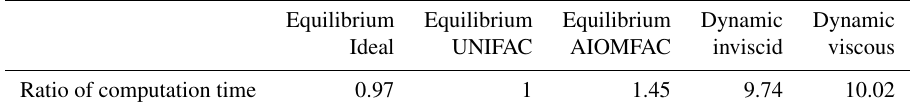
Table 5. Comparison of the time elapsed for the simulations. The elapsed time for the Equilibrium UNIFAC simulation is set to a reference time. Ratios between the reference time and the time elapsed for other simulations are presented.